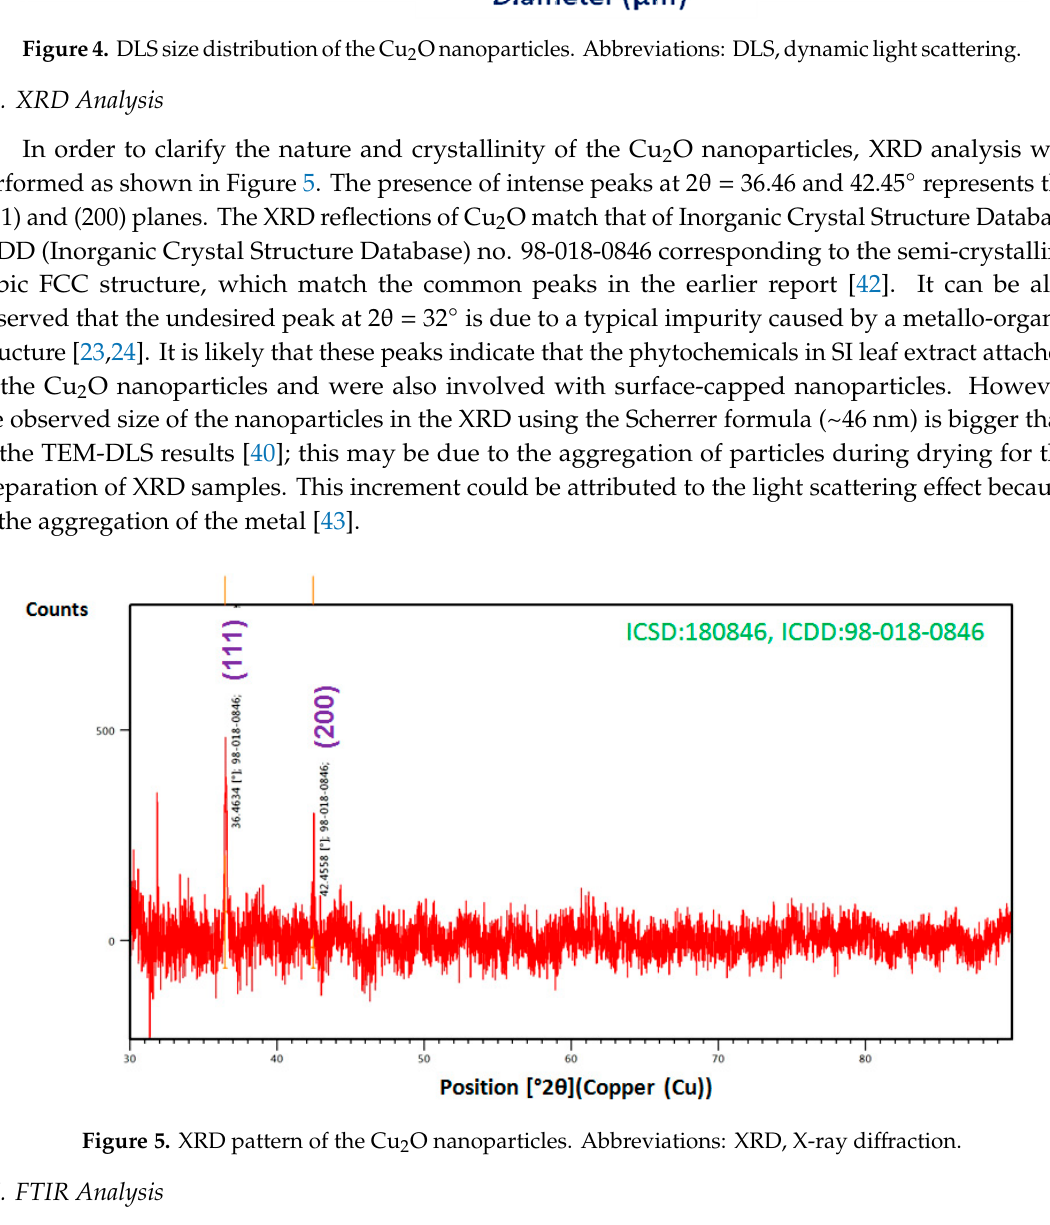
Figure 5. XRD pattern of the Cu 2 O nanoparticles. Abbreviations: XRD, x-ray diffraction.